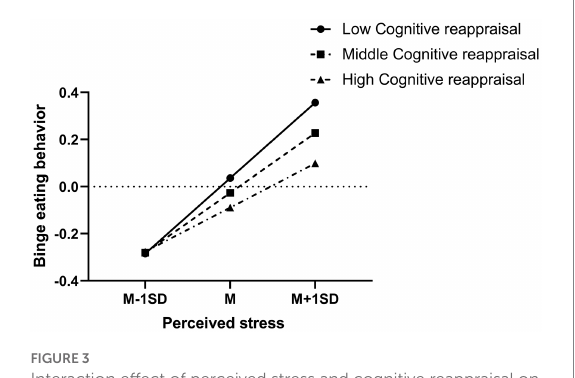
FIGURE 3 Interaction effect of perceived stress and cognitive reappraisal on binge eating behavior. High and low levels of perceived stress and cognitive reappraisal represent one standard deviation above and below the mean,